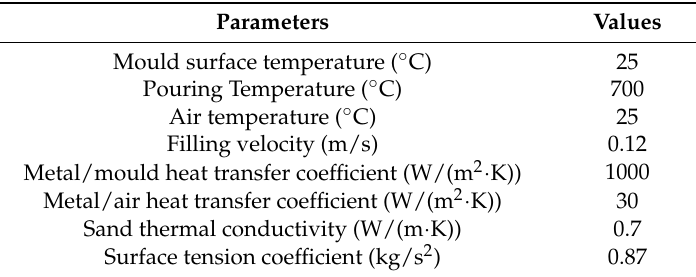
Table 1. Simulation